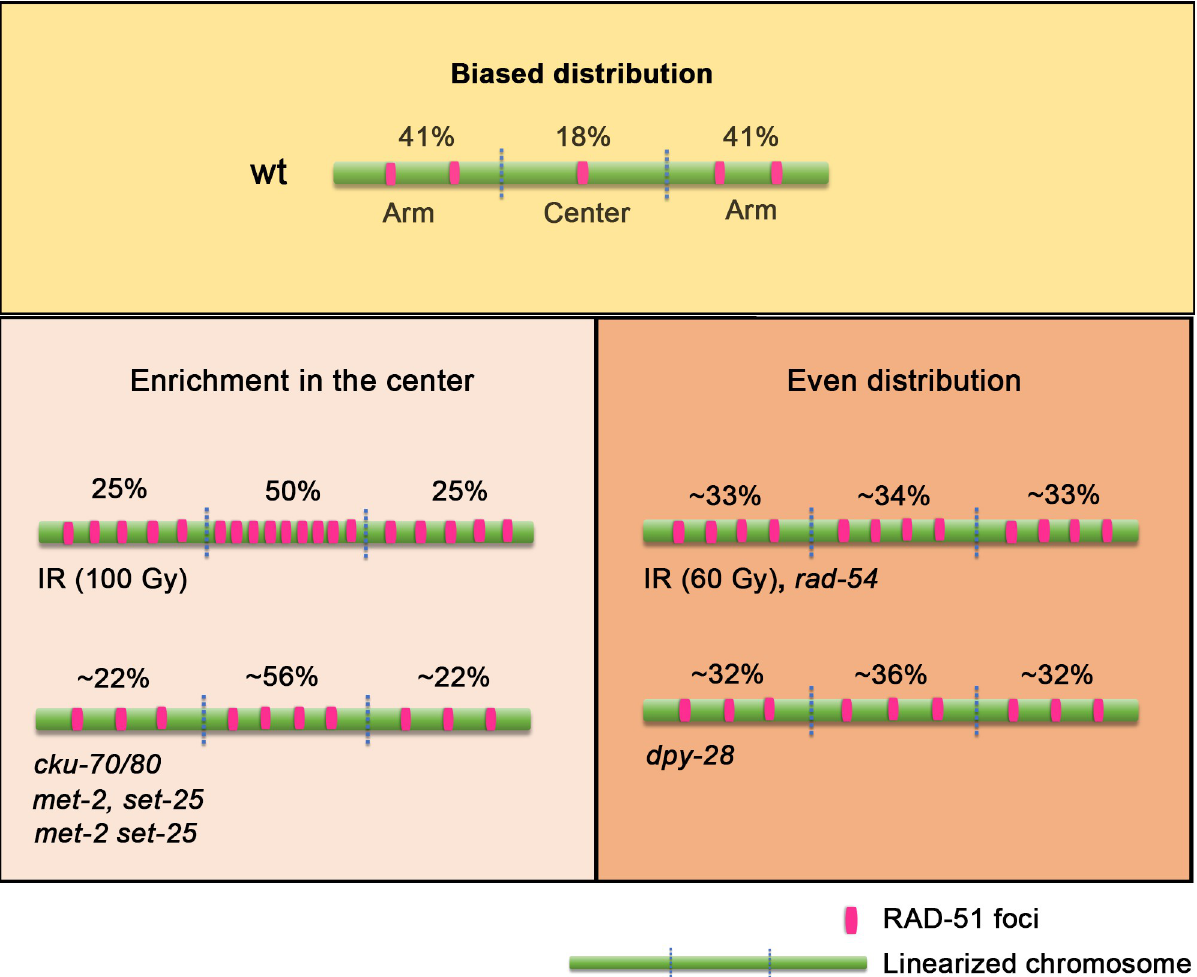
Fig 6. Illustration showing how different factors contribute to the regulation of meiotic RAD-51 foci distribution. Under normal conditions the distribution of RAD-51 foci is biased to the arms of the chromosomes throughout pachytene in wild-type animals. Our analysis identifies various factors contributing to the regulation of meiotic DSB patterning. An enrichment of RAD-51 foci is detected at the center of the chromosomes following exposure to very high doses of exogenous DSBs (100 Gy), when DSB recognition by cKU-70/80 is impaired, and when the chromatin landscape is perturbed ( met-2 , set-25 , met-2 set-25 ). An even distribution of RAD-51 foci throughout the arms and the center of the chromosomes is observed upon intermediate doses of exogenous DSBs (60 Gy), when RAD-51 nucleofilament turnover is blocked ( rad-54 ), and when chromosome compaction ( dpy- 28 ) is altered. An average of the percentages of RAD-51 foci observed at the arms or the center during mid-pachytene are shown above each chromosome. Note that the percentages above each of the arms are arbitrarily assigned since we cannot make a distinction between right or left arms. Chromosome axes are indicated in green and RAD-51 foci in